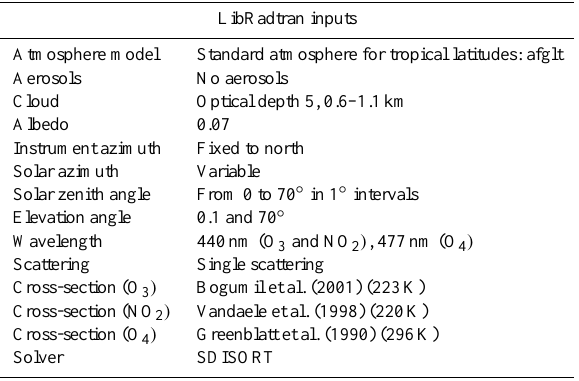
Table 2. Input parameters used in libRadtran for the optical path